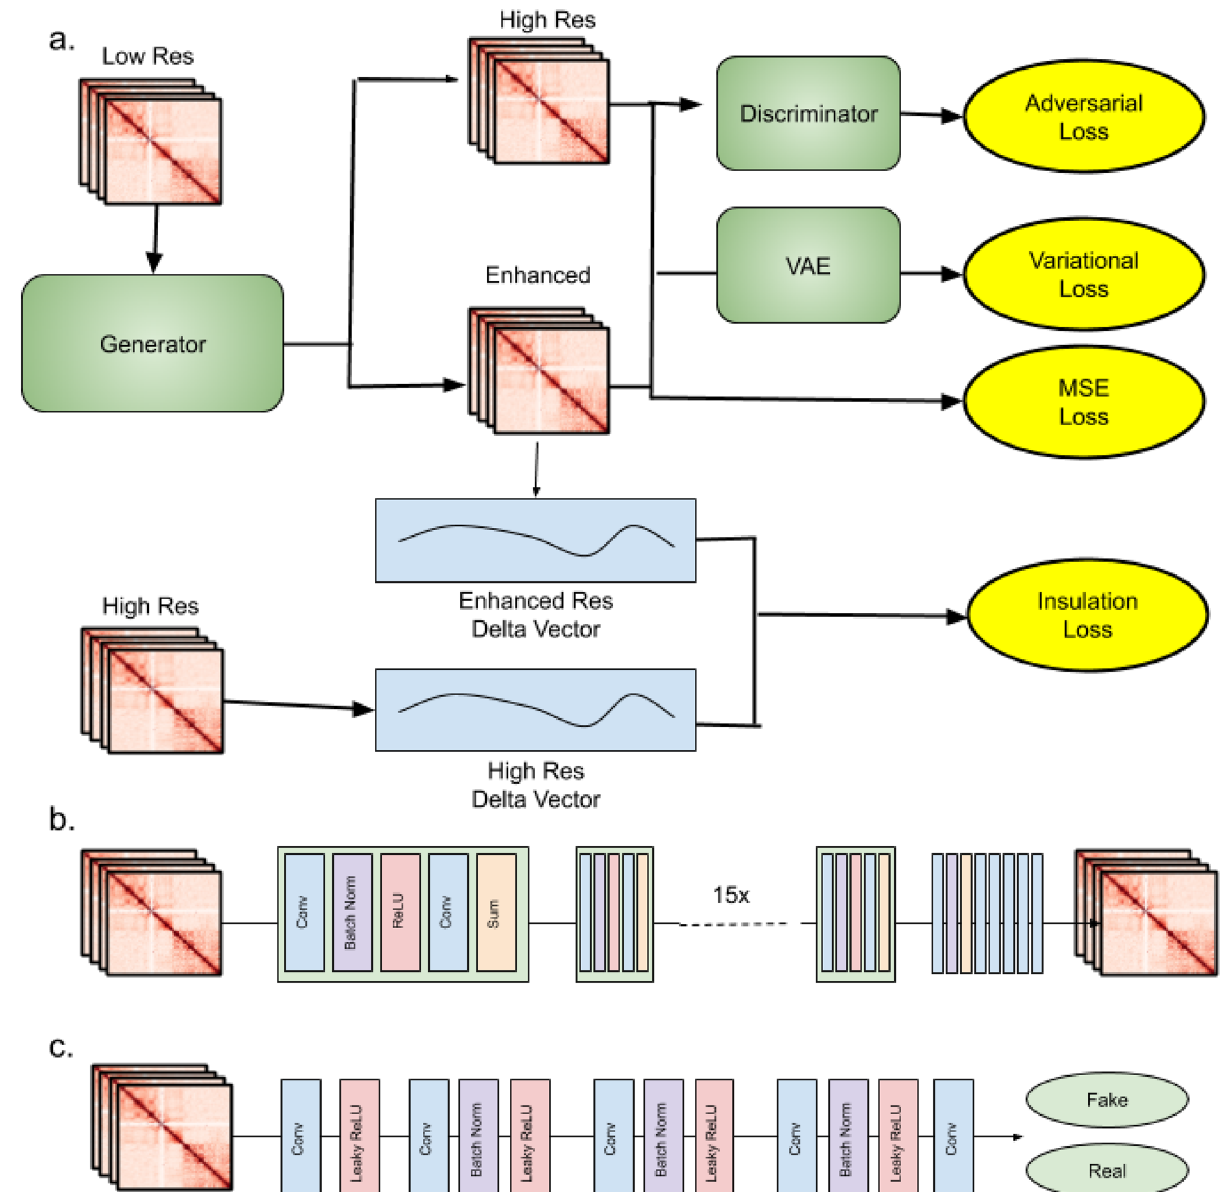
Figure 1. VEHiCLE architecture: ( a ) overview of training strategy, ( b ) generator architecture, ( c ) discriminator